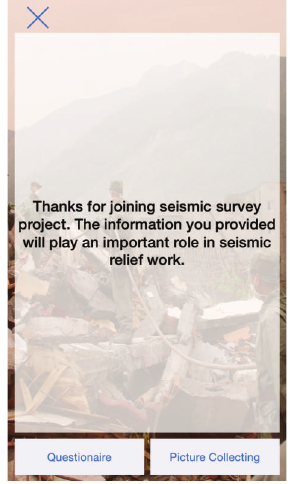
Figure 14: Screenshot of seismic